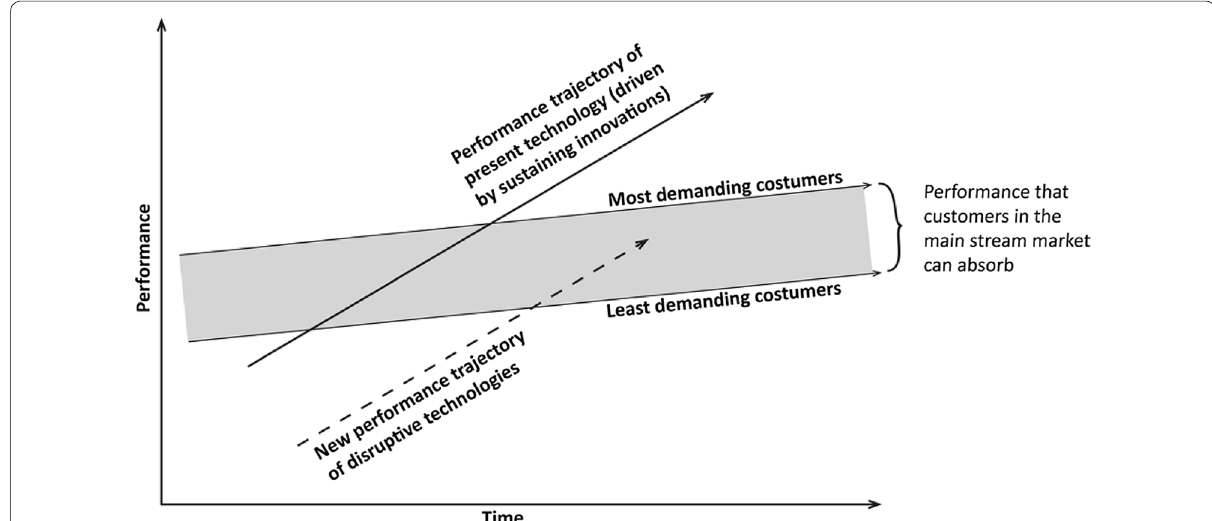
Fig. 1 Disruptive innovation. The graph outlines how the disruptive innovation enters the market in it’s own trajectory to the right of the original technology trajectory. Improvement of the original technology within one trajectory is considered sustaining innovation. From Christensen, Clayton M.: The innovator’s dilemma: when new technologies cause great firms to fail